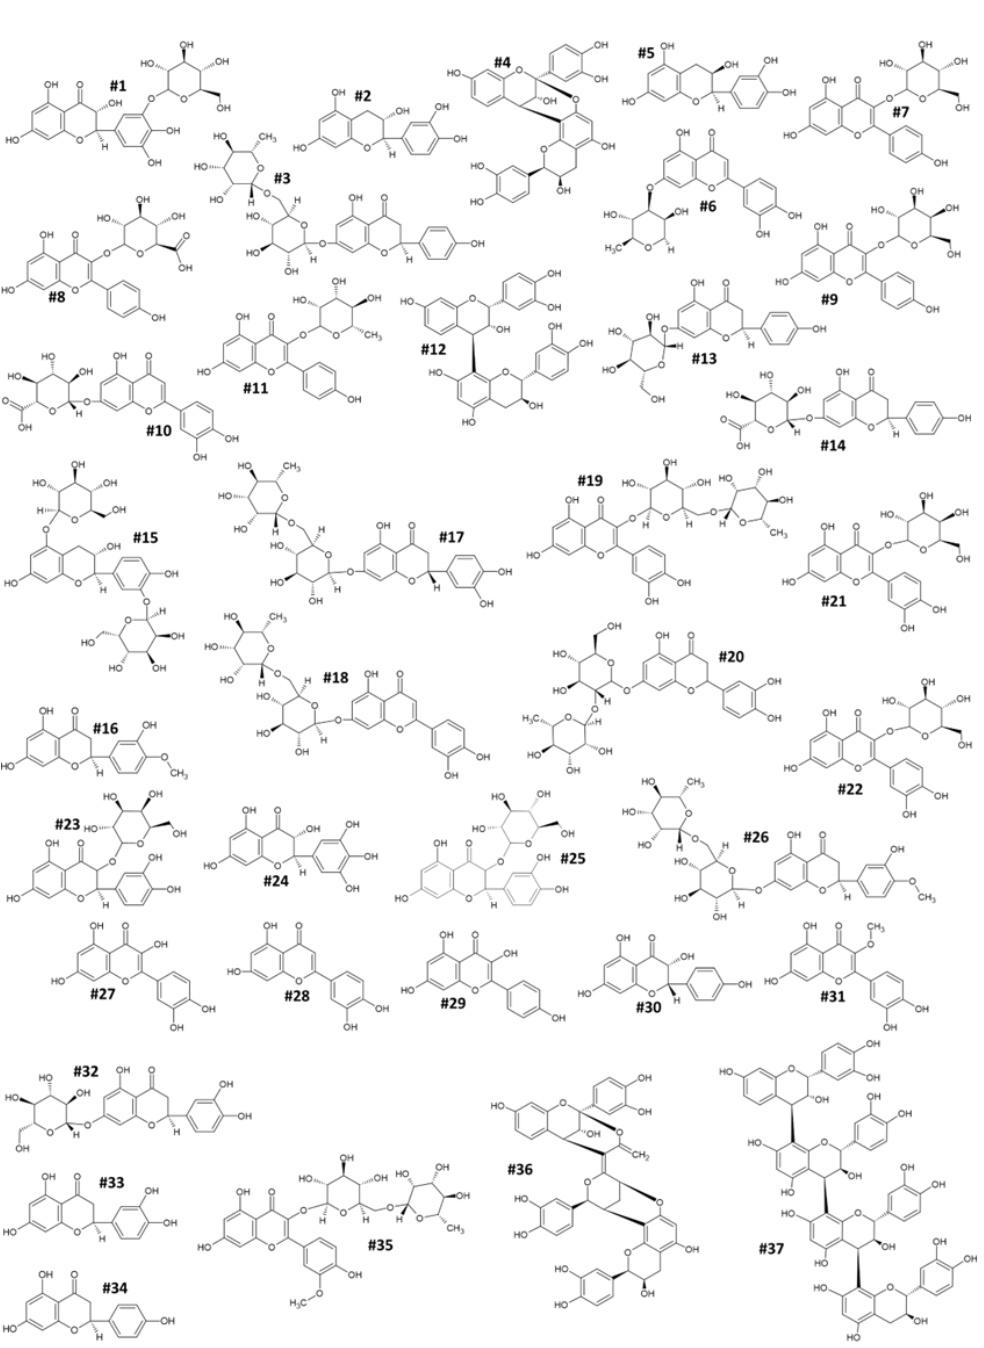
Figure 4. Structure formulae of the bioactive compounds identified and quantified in pulp and peel of peach fruit extracts. The number shown next to the different chemical structures identifies the molecule according to the numbering shown in Table 1.